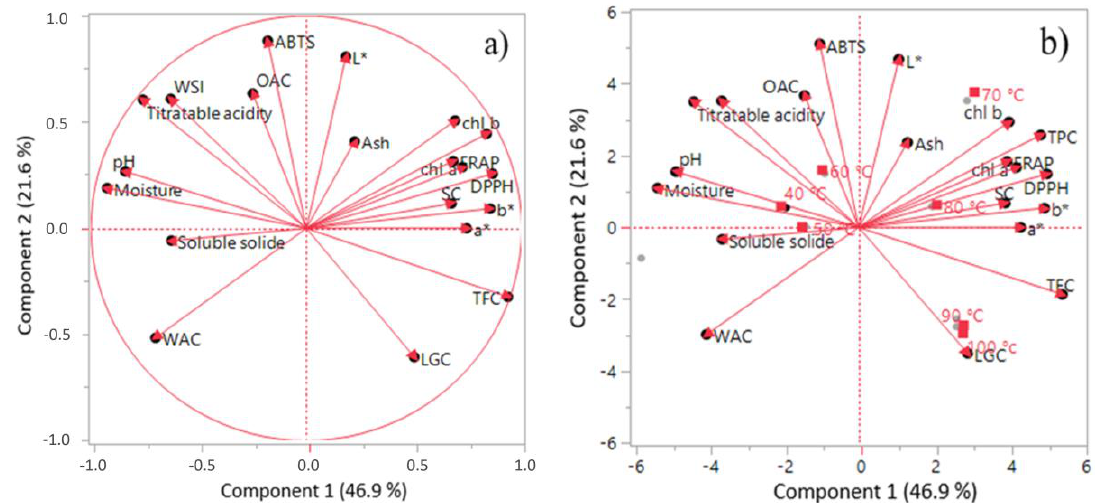
Figure 6. Principal Component Analysis. “( a ) Presents the distribution of the studied parameters and the relationships between them”; “( b ) presents the distribution of the treatment temperature with the studied